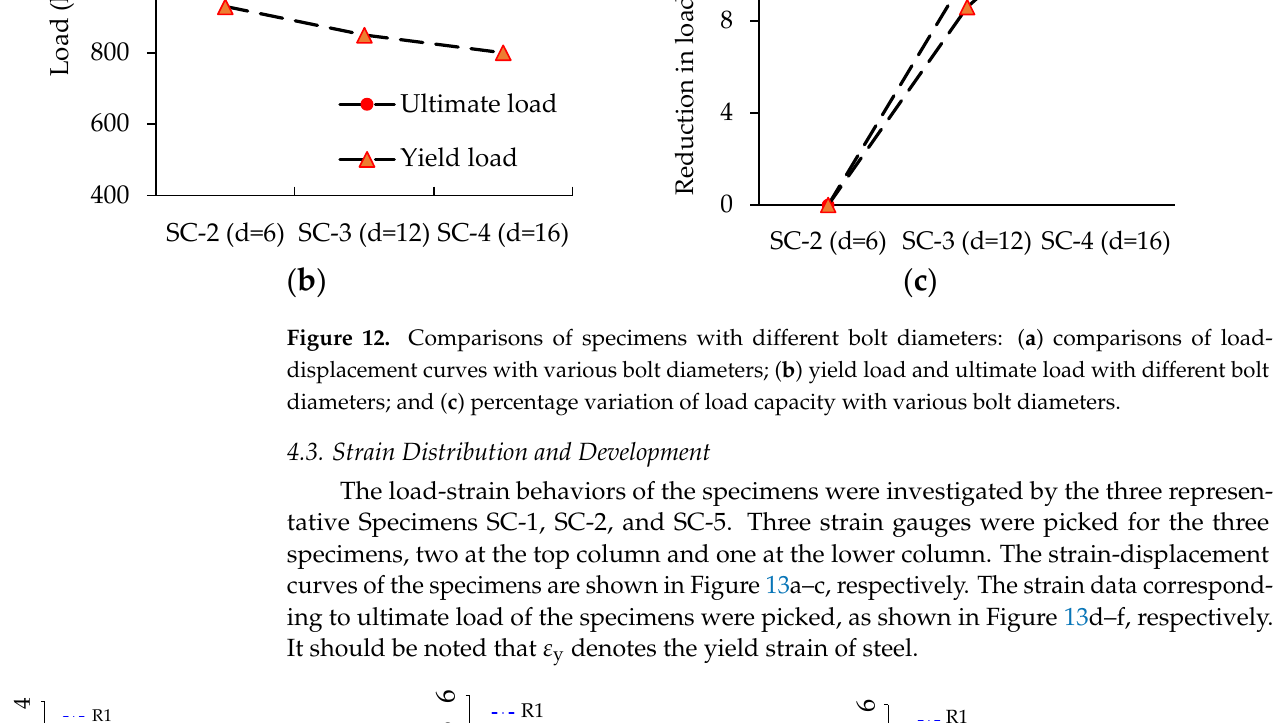
Figure 12. Comparisons of specimens with different bolt diameters: ( a ) comparisons of load-dis- placement curves with various bolt diameters; ( b ) yield load and ultimate load with different bolt diameters; and ( c ) percentage variation of load capacity with various bolt diameters.